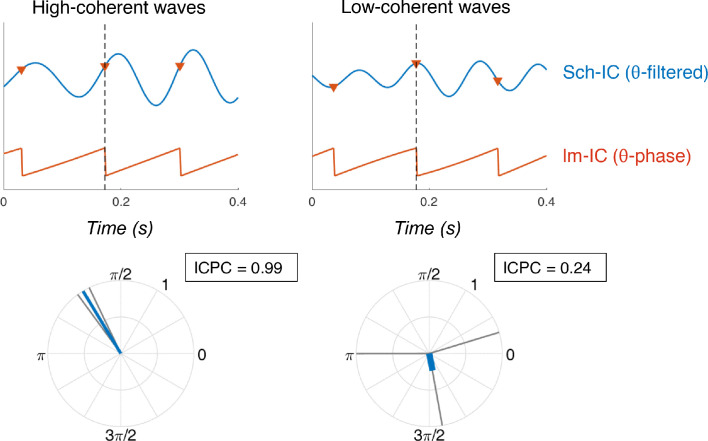
Examples of synchronization using ICPC.(Top) Temporal traces of Sch-IC (filtered at theta frequency) and the theta phase of lm-IC. Each step in the saw-tooth signal (π radians) is marked with a red triangle and corresponds to a peak in the theta oscillation of lm-IC. Black dashed lines indicate the cycle under consideration. (Bottom) The synchronization between signals is measured by computing the ICPC using the previous, present and consecutive cycles.